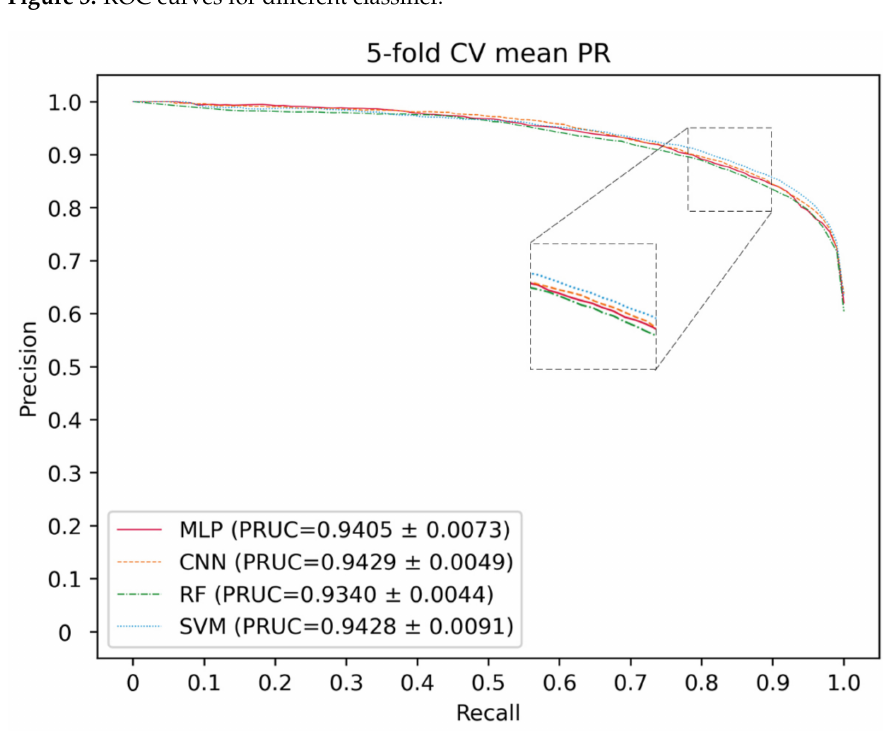
Figure 4. PR curves for different